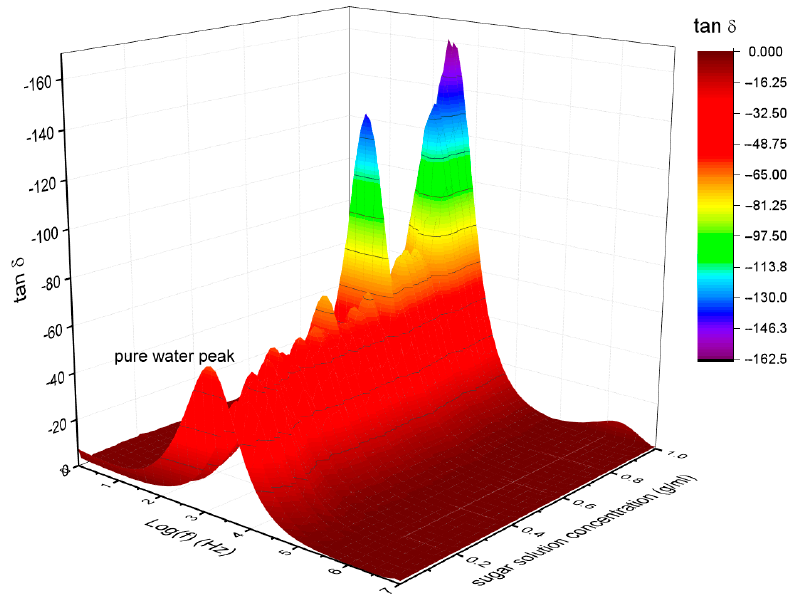
Figure 6. Tan δ as a function of frequency for different sucrose concentrations.